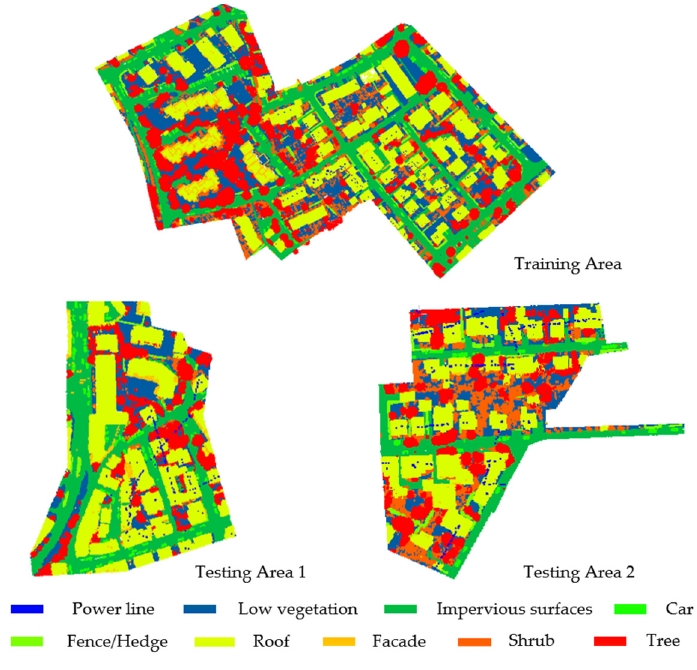
Figure 7. Vaihingen Dataset.